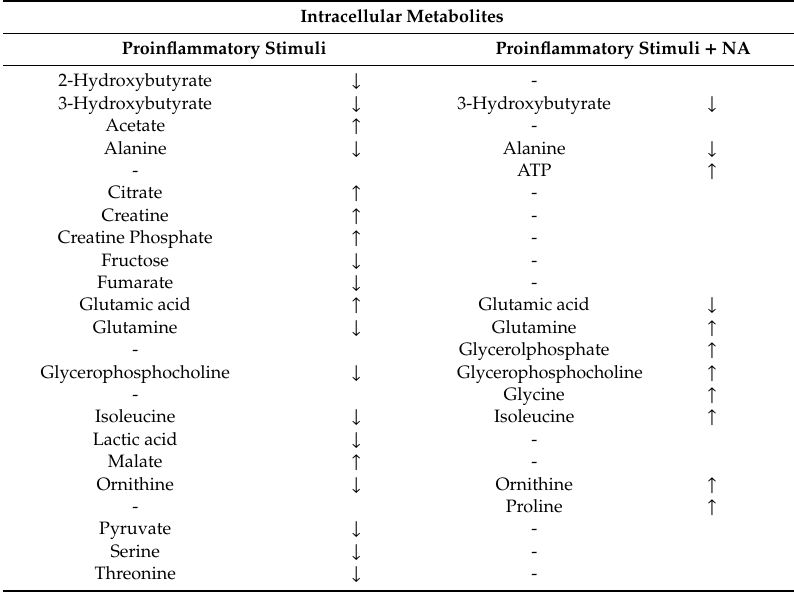
Figure 3. Significantly different intracellular metabolites measured in Caco-2 cells by 1 H-NMR and GC-MS. Metabolites are indicated as peak areas normalized for total protein content and total area ( n = 3). Statistical analysis was performed using an unpaired Student’s t -test. * p < 0.5, ** p < 0.01. Table 1. Intracellular and extracellular metabolites significantly altered by treatment with proinflammatorystimuli(LPSandIL-1 β )andbytreatmentwithproinflammatorystimuliincombination with NA in Caco-2